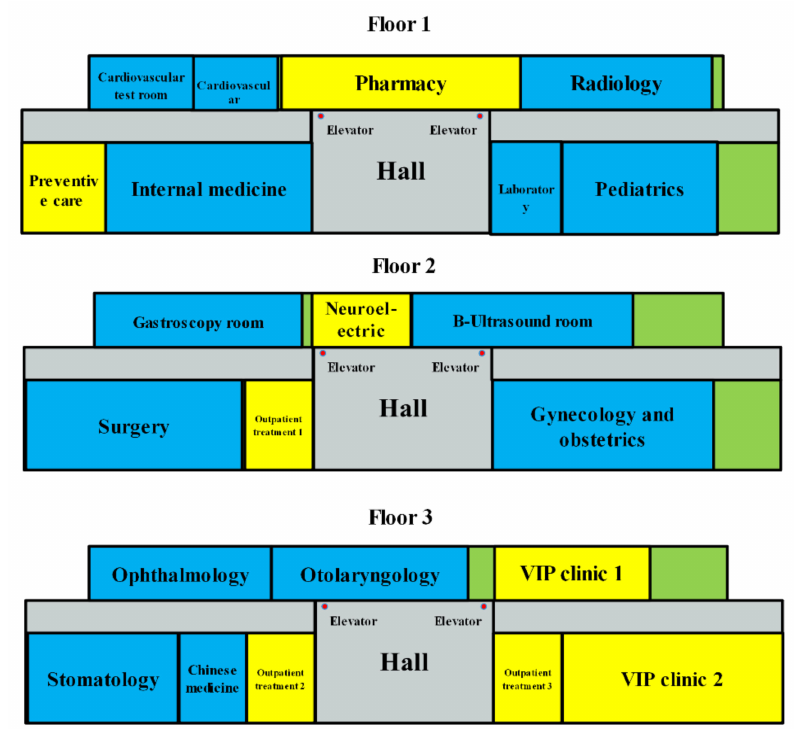
Figure 7. The layout with minimal total movement